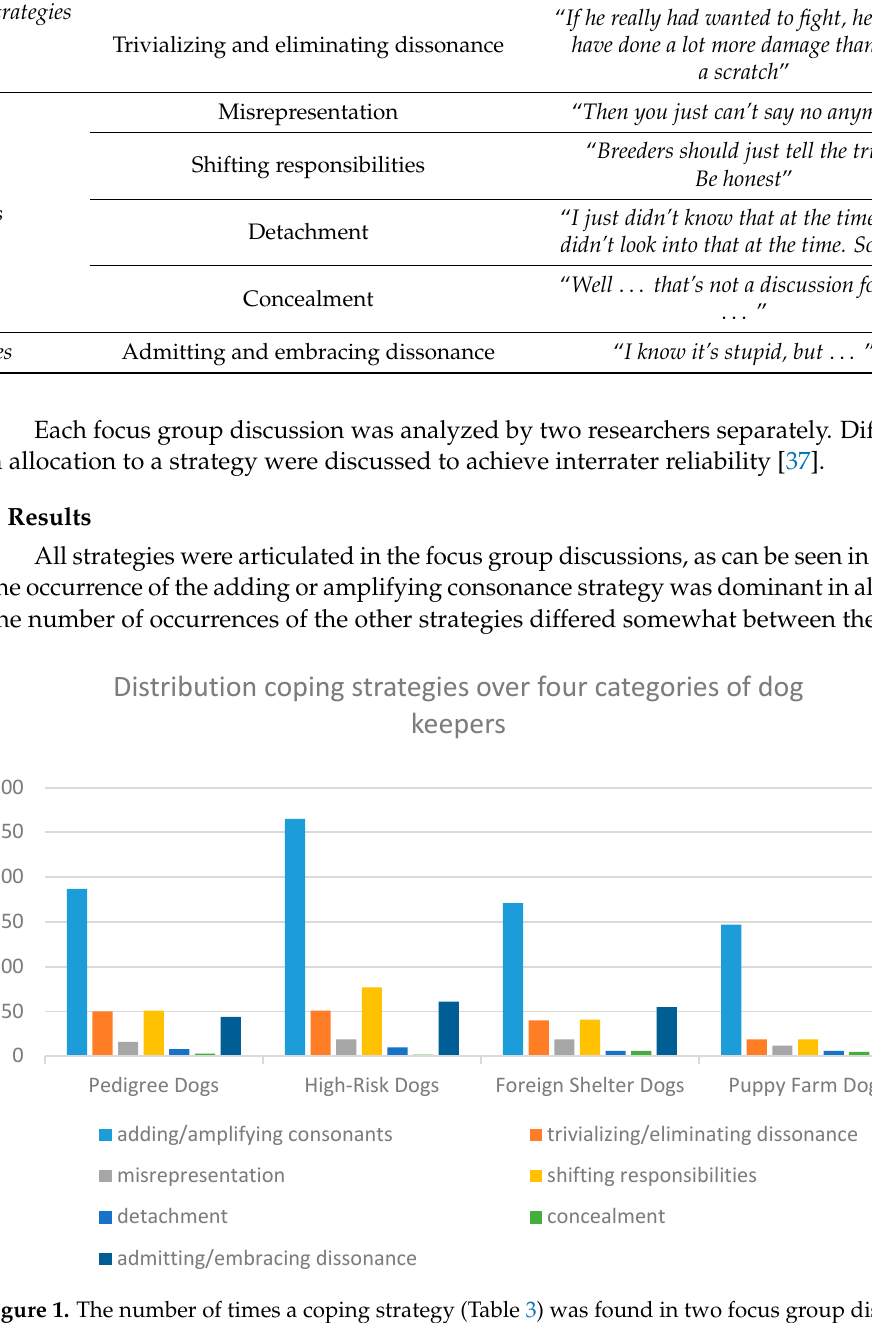
Figure 1. The number of times a coping strategy (Table 3) was found in two focus group discussions of each category of dog keepers.